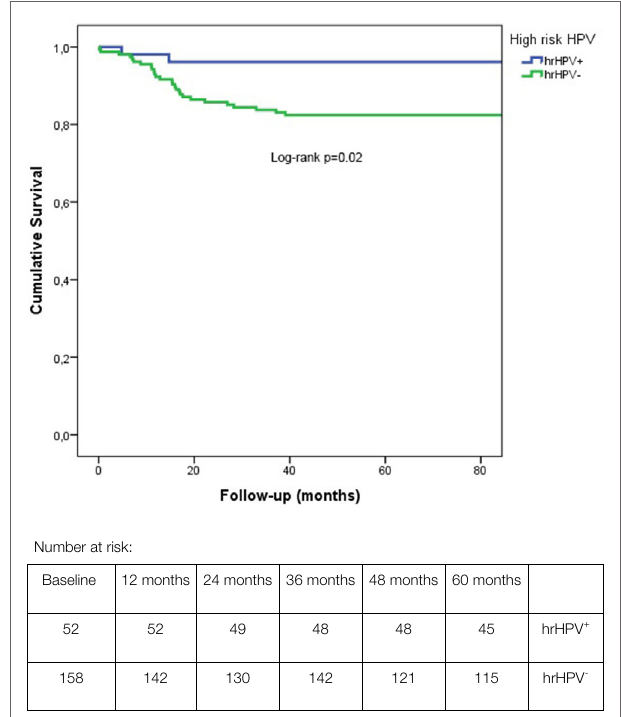
FigUre 1 | Kaplan–Meier survival plots with log-rank test analysis of high-risk HPV-positive and -negative penile cancer